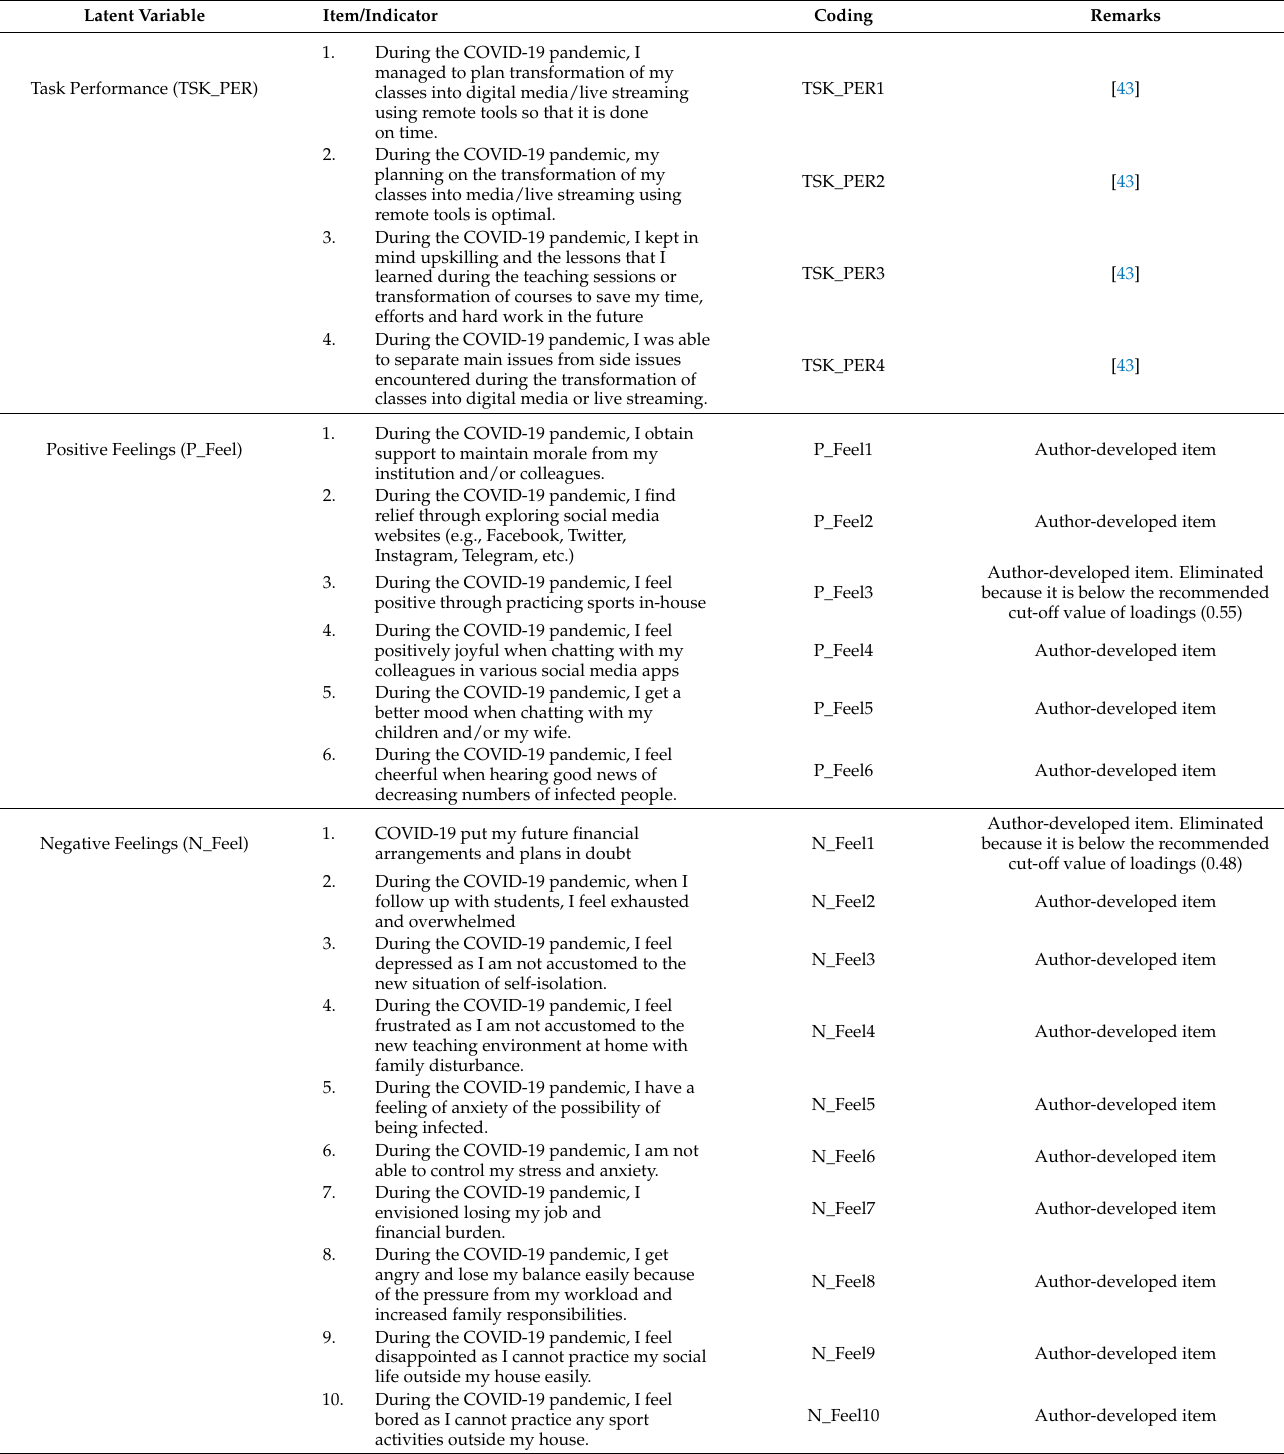
Table A1. Survey